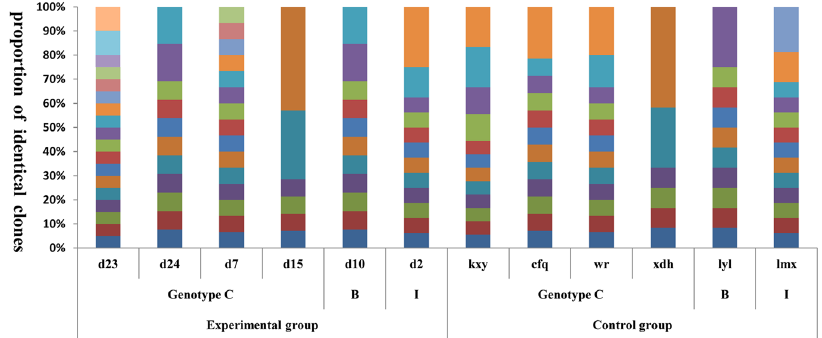
Figure 1. HBV full-length quasispecies in the experimental group and control group. The vertical bars indicate the proportion of viral quasispecies within each patient. Each color represents one kind of quasispecies. Y axis: proportion of identical clones; X axis: each patient.